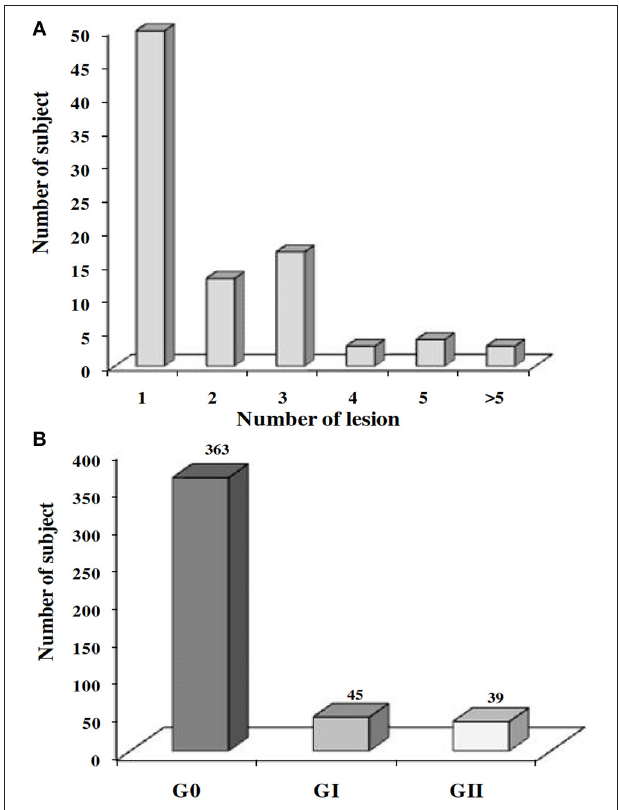
FIGURE 5 | Prevalence of ZCL after one transmission season of L. major . Prevalence of the ZCL according to (A) the number of lesions developed or (B) the severity of the disease. G0, no ZCL lesion; GI, individuals developing a mild ZCL (severity score contained with the interval [0–20]); GII, individuals developing an intermediate or severe leishmaniasis (severity score ≥ 20).